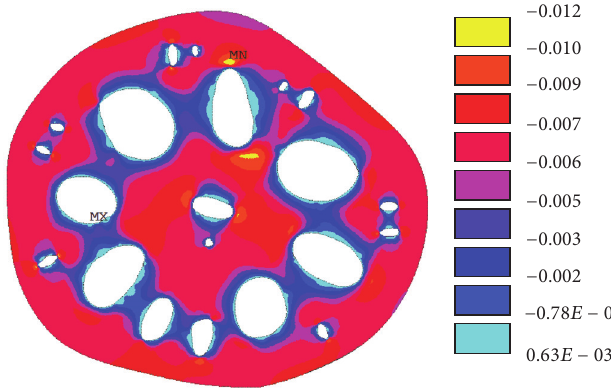
Figure 6: Tensile stress (MPa) distribution in the cross-sectional area of the lotus root.